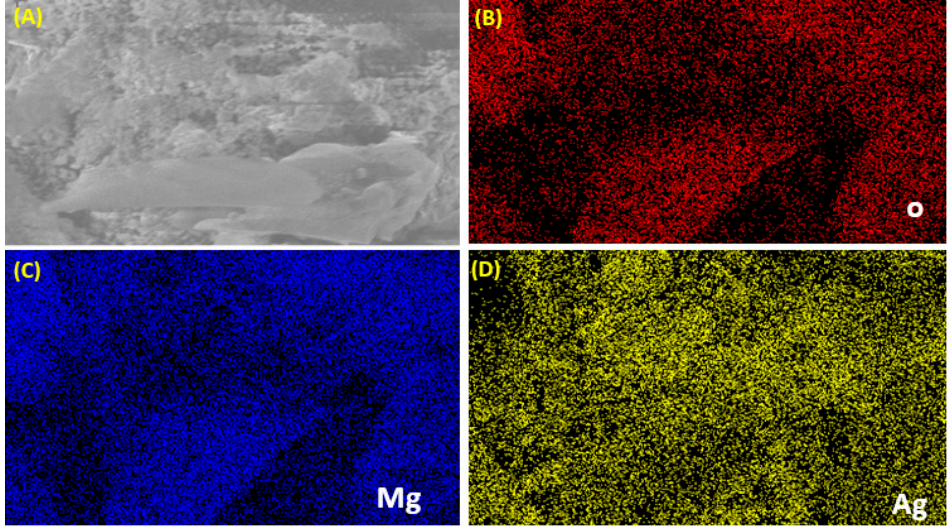
Figure 5. Elemental image mapping of 7.5% Ag ‐ doped MgO NPs ( A ), oxygen (O) ( B ), magnesium (Mg) ( C ), and silver (Ag) ( D ).